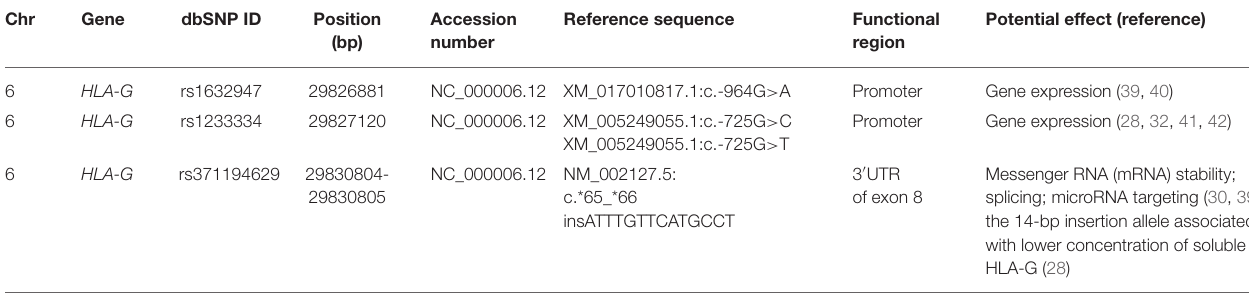
TABLE 1 | Summary of tested single nucleotide polymorphisms (SNPs).